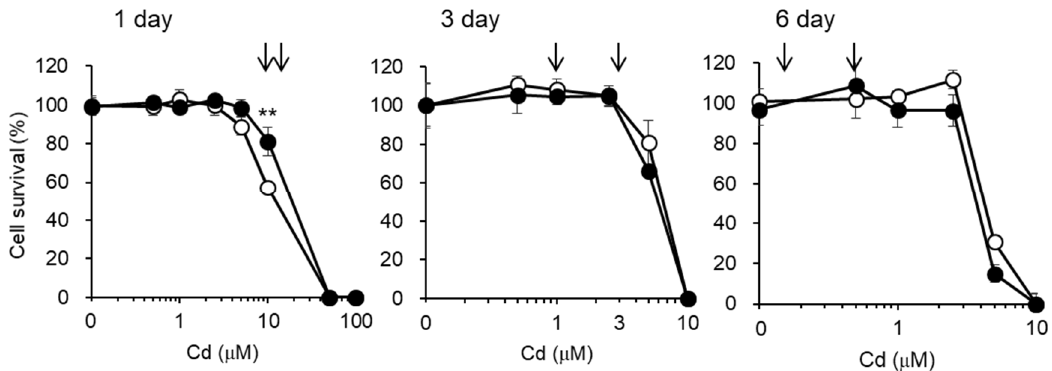
Figure 3. Cytotoxicity of Cd in S1 and S2 cells. S1 (open circles) and S2 (closed circles) cells cultured in 96-well plates were incubated with the indicated concentrations of CdCl 2 for 1, 3, and 6 days. Cell viability was determined by alamarBlue ® assay and expressed as a percentage of the nontreated cells. From these results, the Cd concentrations to be used in the subsequent experiments were determined (arrows). Data are presented as means ± SD ( n = 4–6). Statistically significant difference between S1 and S2 cells was indicated as ** p < 0.01.